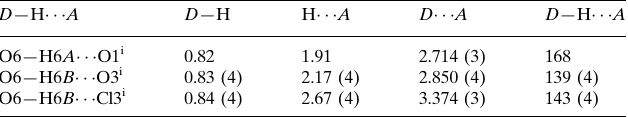
Hydrogen-bond geometry (A˚ , (cid:2)